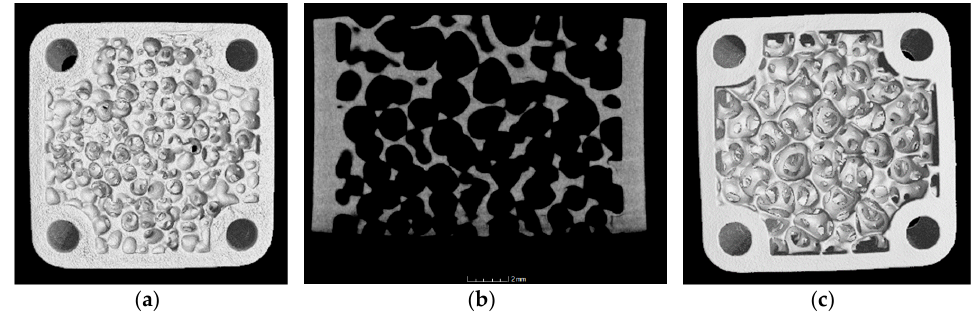
Figure 11. CT scan images of the sintered alumina component (18 × 18 × 10 mm³) with graded porosity: bottom ( a ), top ( c ), and cross-section image recalculated from the CT scan ( b ).